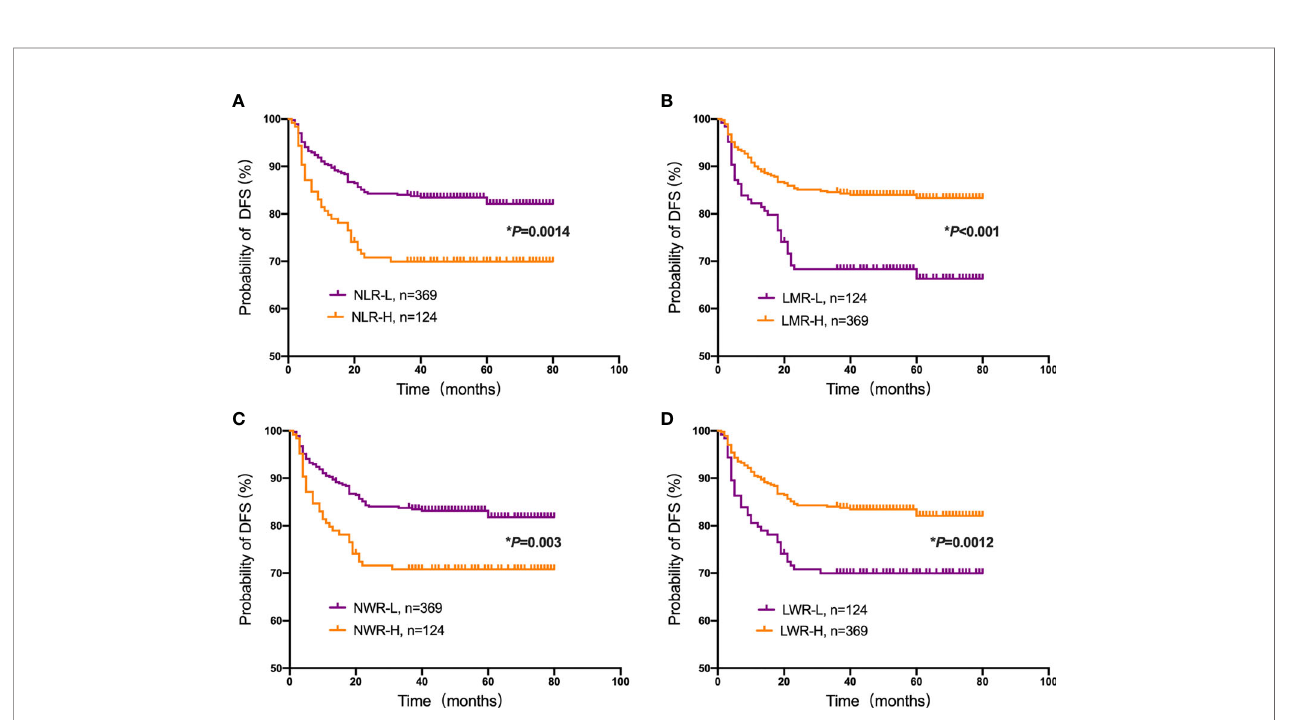
FIGURE 3 | Kaplan-Meier plots for the probability of disease-free survival (DFS). DFS rates of the patient subgroups strati fi ed by the (A) neutrophil-to-lymphocyte ratio (NLR), (B) lymphocyte-to-monocyte ratio (LMR), (C) neutrophil-to-white blood cell ratio (NWR) and (D) lymphocyte-to-white blood cell ratio (LWR). Asterisks (*) indicate statistical signi fi